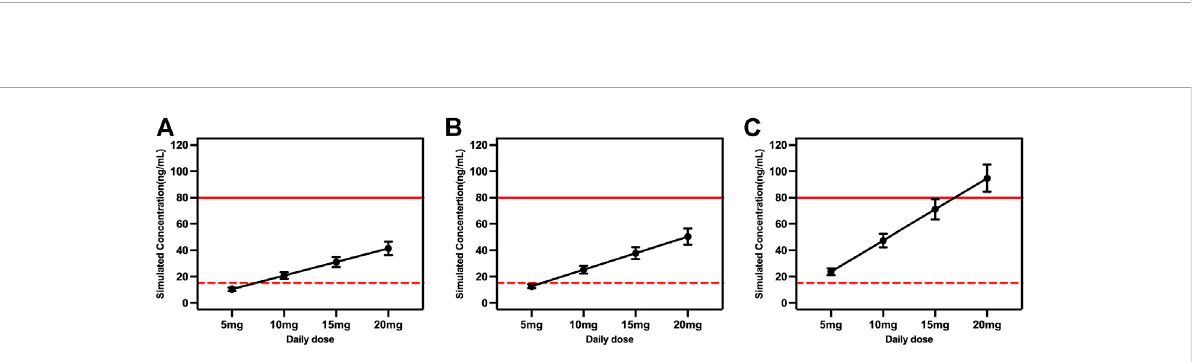
FIGURE 4 Simulated concentrations for ages ≥ 18 and < 65 years in (A) extensive metabolizers; (B) immediate metabolizers, and (C) poor metabolizers at different daily doses. The red dash lines represented 15 ng/ml, and the red solid lines represented 80